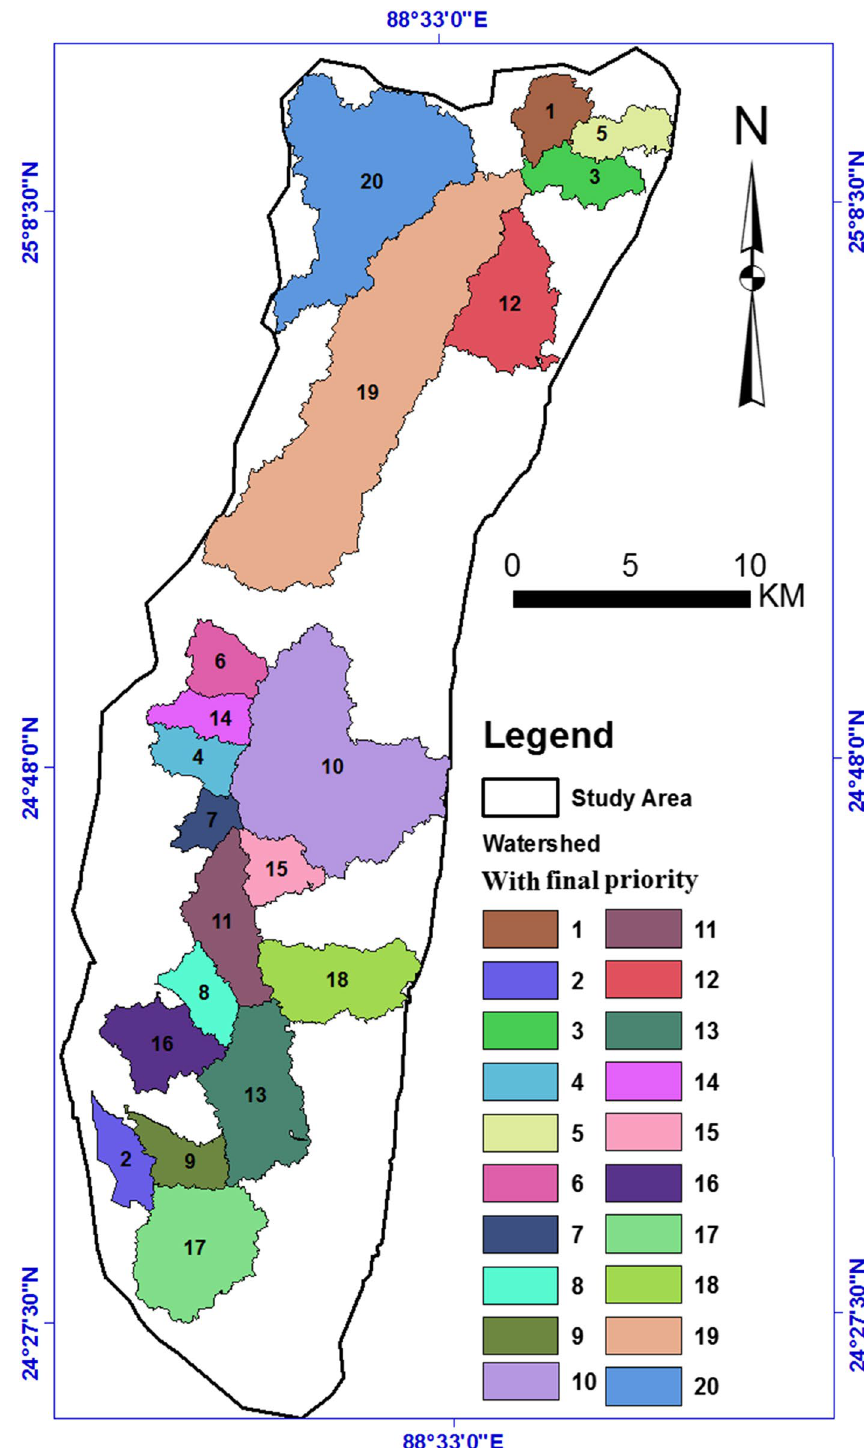
Fig. 10 Final priority map shows ranking for soil and water conservation